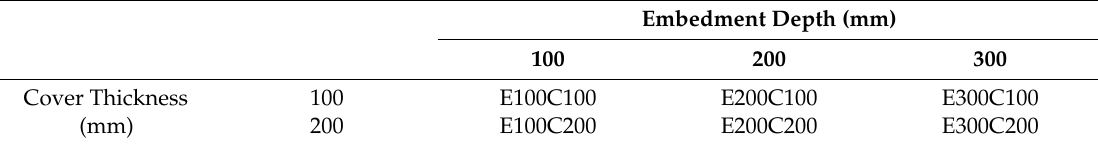
Figure 4. Specimen for numerical verification. Table 1. Designation of the specimens in the numerical verification.